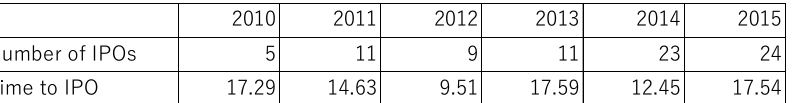
Table 1. Average time (years) to